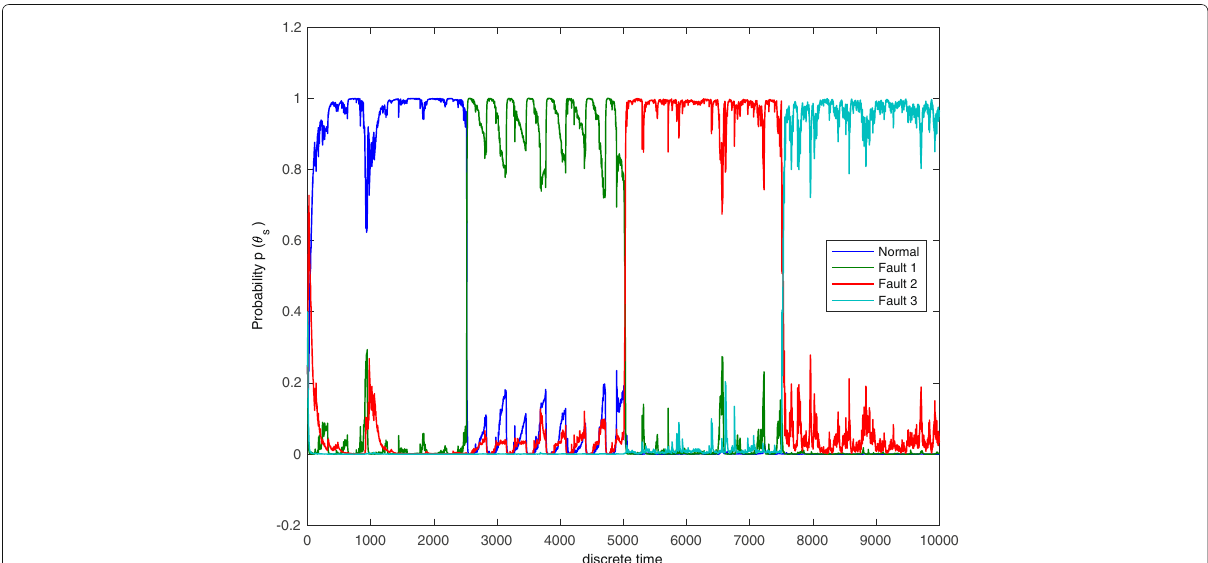
Fig. 5 Probability of which operation state the oscillator (46) is in conditional on the measurements. Probabilities are computed using formula (29)